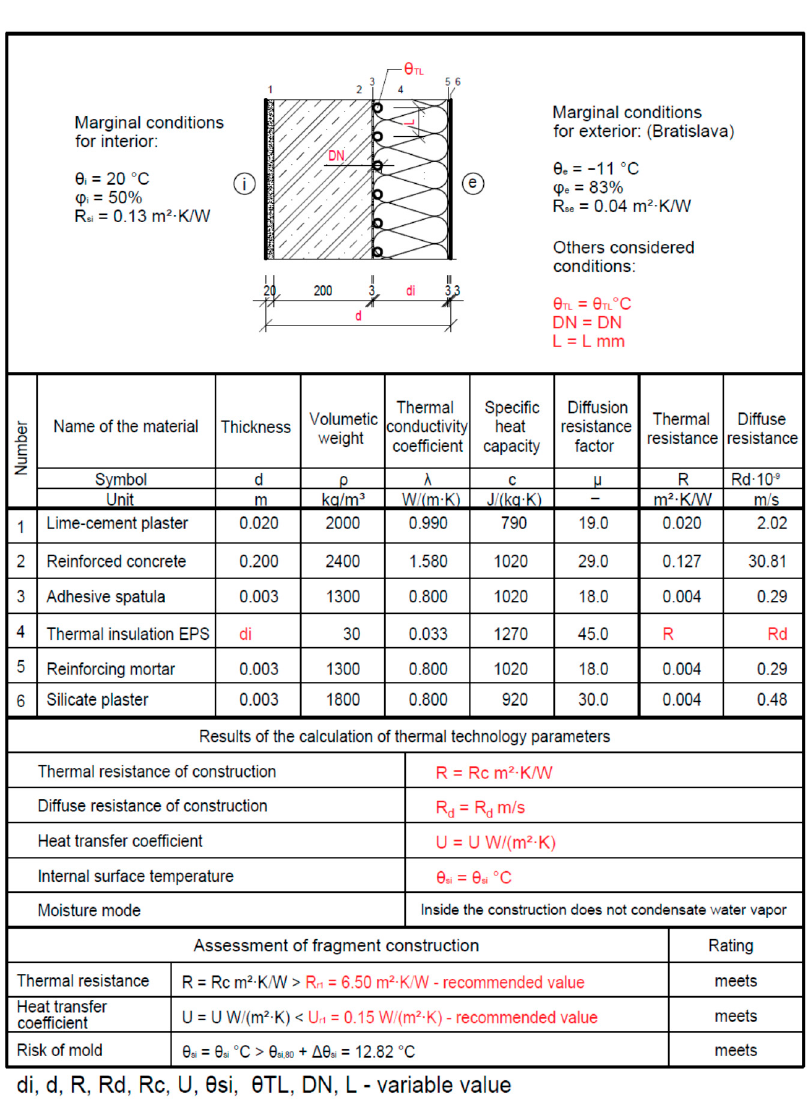
Figure 1. Thermal technical properties and assessment of a multilayer perimeter wall fragment [4] .